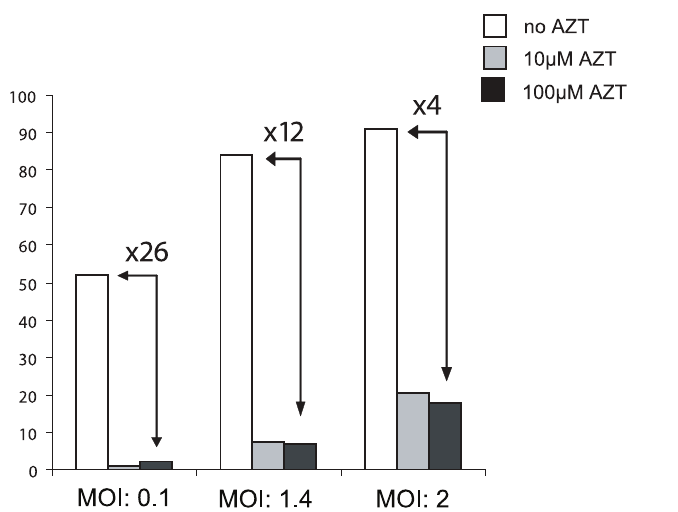
Figure 5. Effect of increasing MOI on infectivity under AZT treatment. Indicator FAG cells were infected with increasing MOIs in the presence or absence of AZT at two different concentrations, 10 m M and 100 m M. Forty eight hpi, GFP expression was monitored by flow cytometry. The values represented the average of three independent experiments.